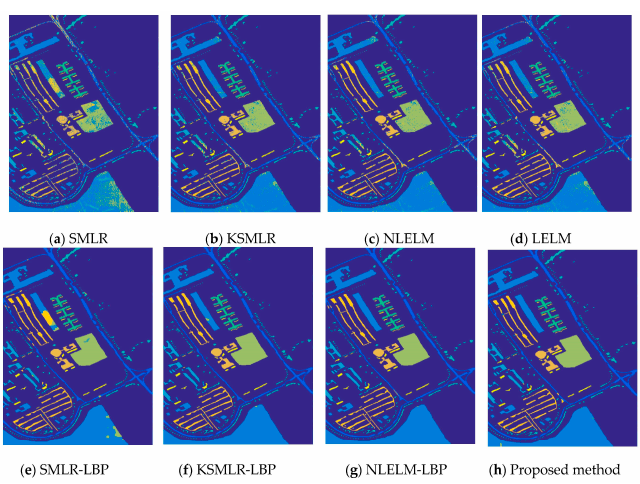
Figure 7. Pavia University training maps.